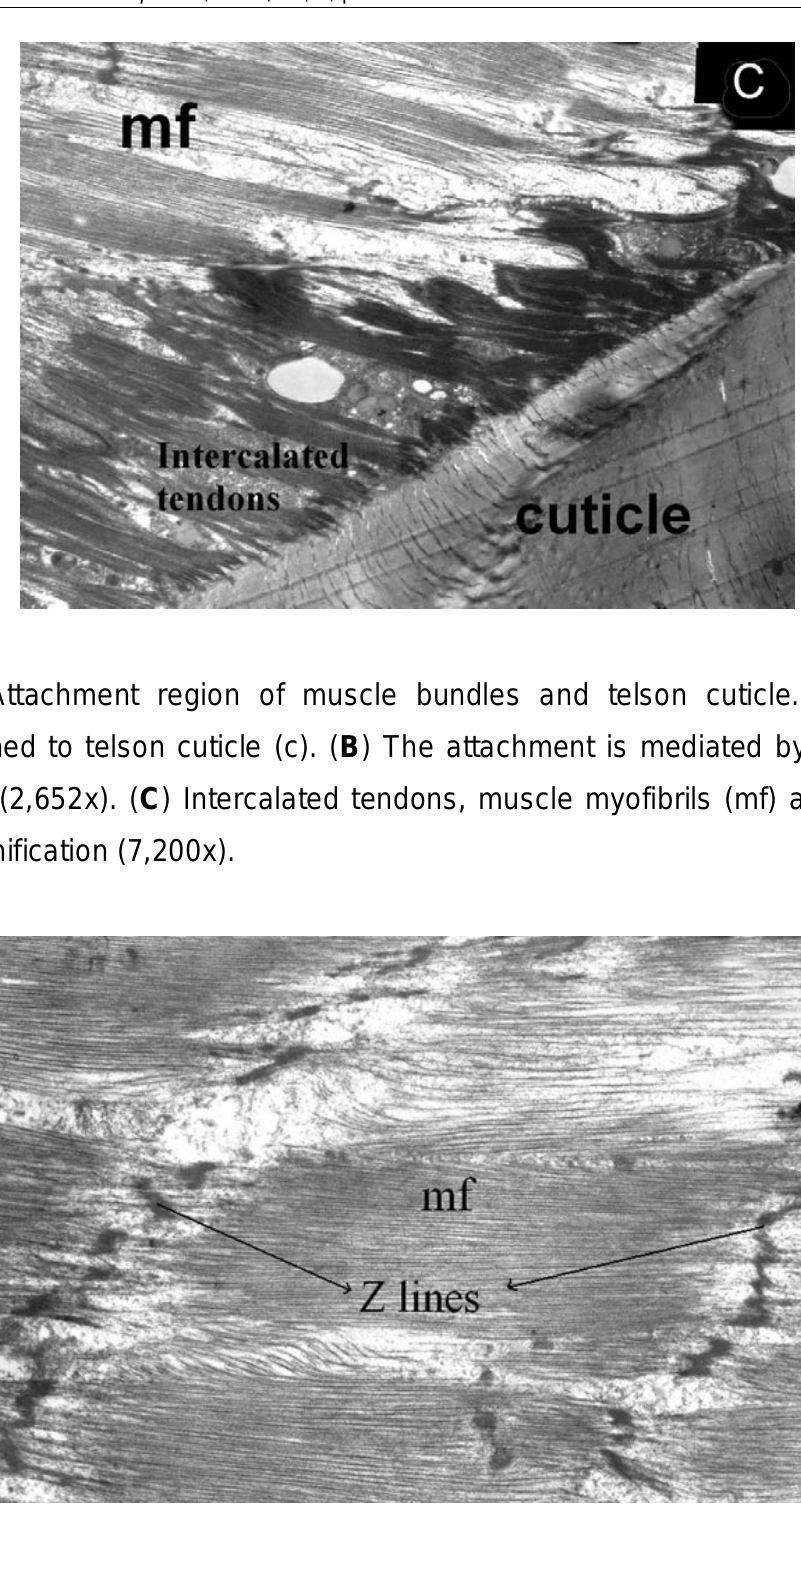
Figure 3. Two Z lines and myofibrils (mf) are shown in muscle layer in a longitudinal section. The muscle layer Z lines present irregular structure